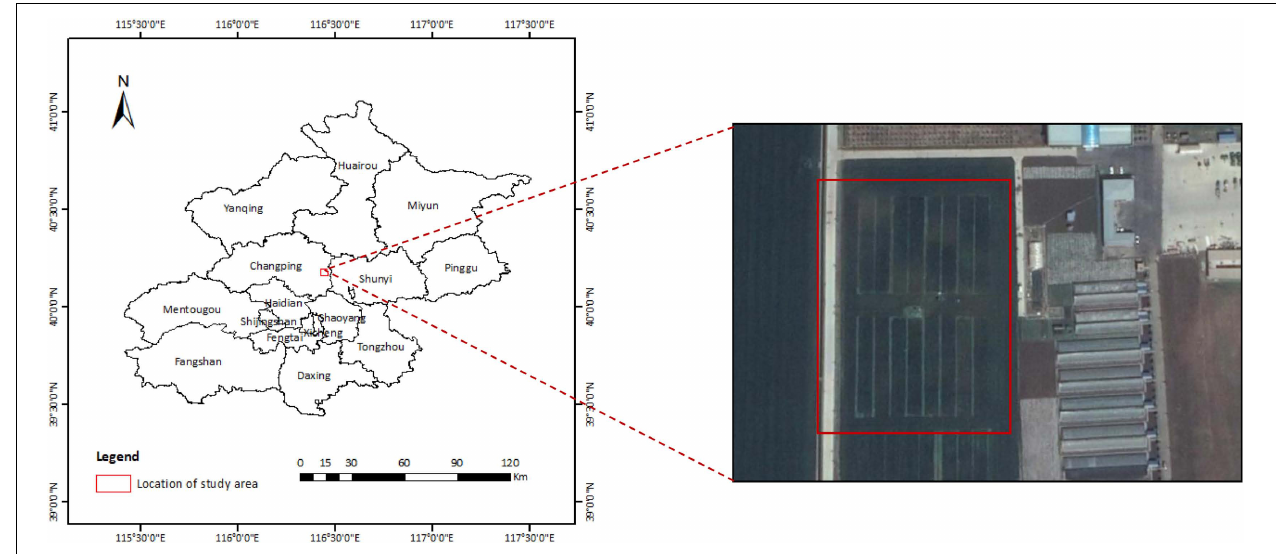
FIGURE 1 | The overview map of study area (cited from Kong et al., 2021).